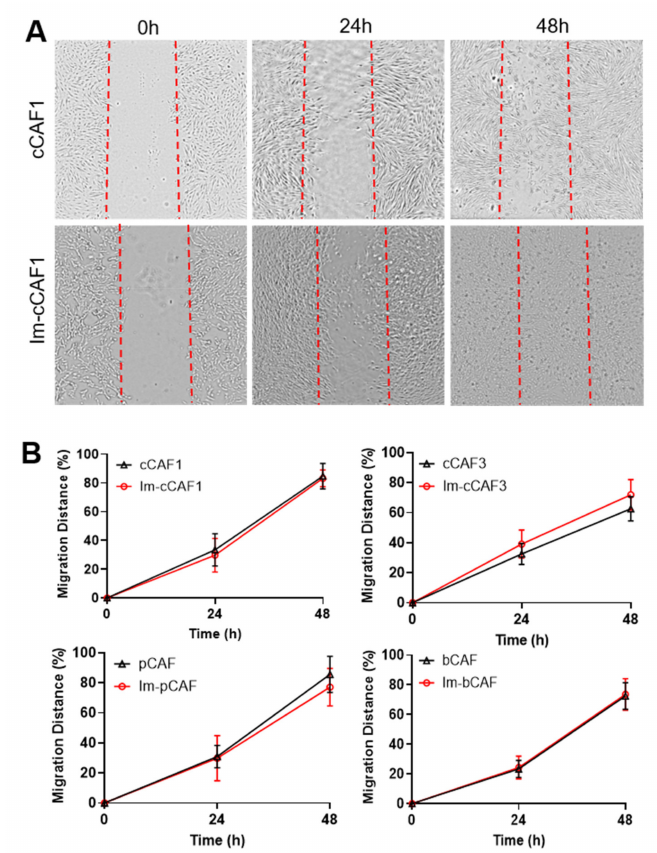
Figure 4. Immortalized CAFs are migratory. ( A ) Representative images of migration of CAFs across a scratch at 0, 24, and 48 h after the scratch was made. Dotted lines depict where the scratch was made. ( B ) The proportion of the original scratch area closed after 24 and 48 hrs. Data depicts evaluations of primary cells at P3 and immortalized cells from P4–P9. The line graph represents the mean value ± SD of 10–16 replicates per cell line, from 2 independent